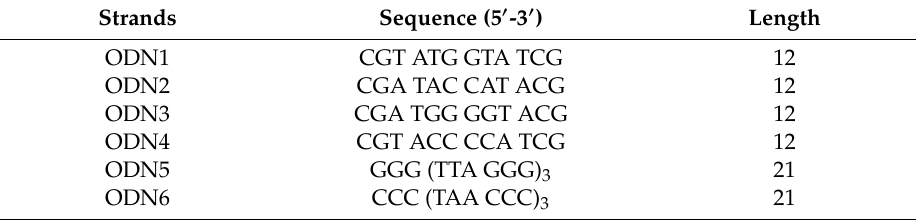
Table 1. The sequences of the single stranded (ss) oligodeoxynucleotides (ODN) used in this study.